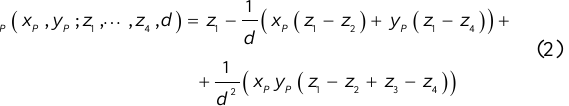
the cell, in order to evaluate the average standard deviation.